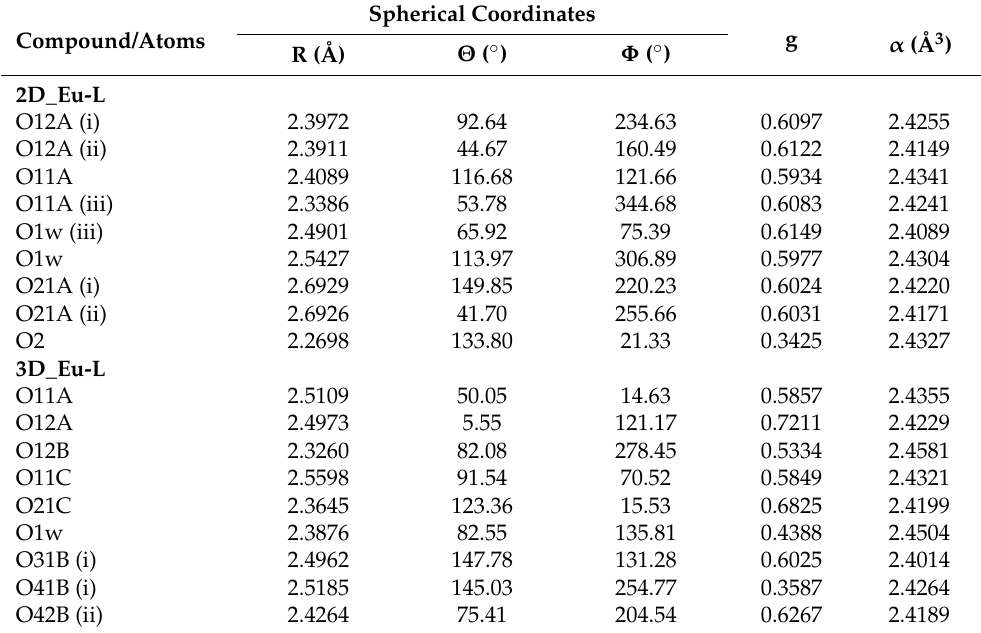
Table 5. Spherical atomic coordinates, charge factors ( g ), and polarizabilities ( α ) for compounds 2D_Eu-L and 3D_Eu-L 1 .